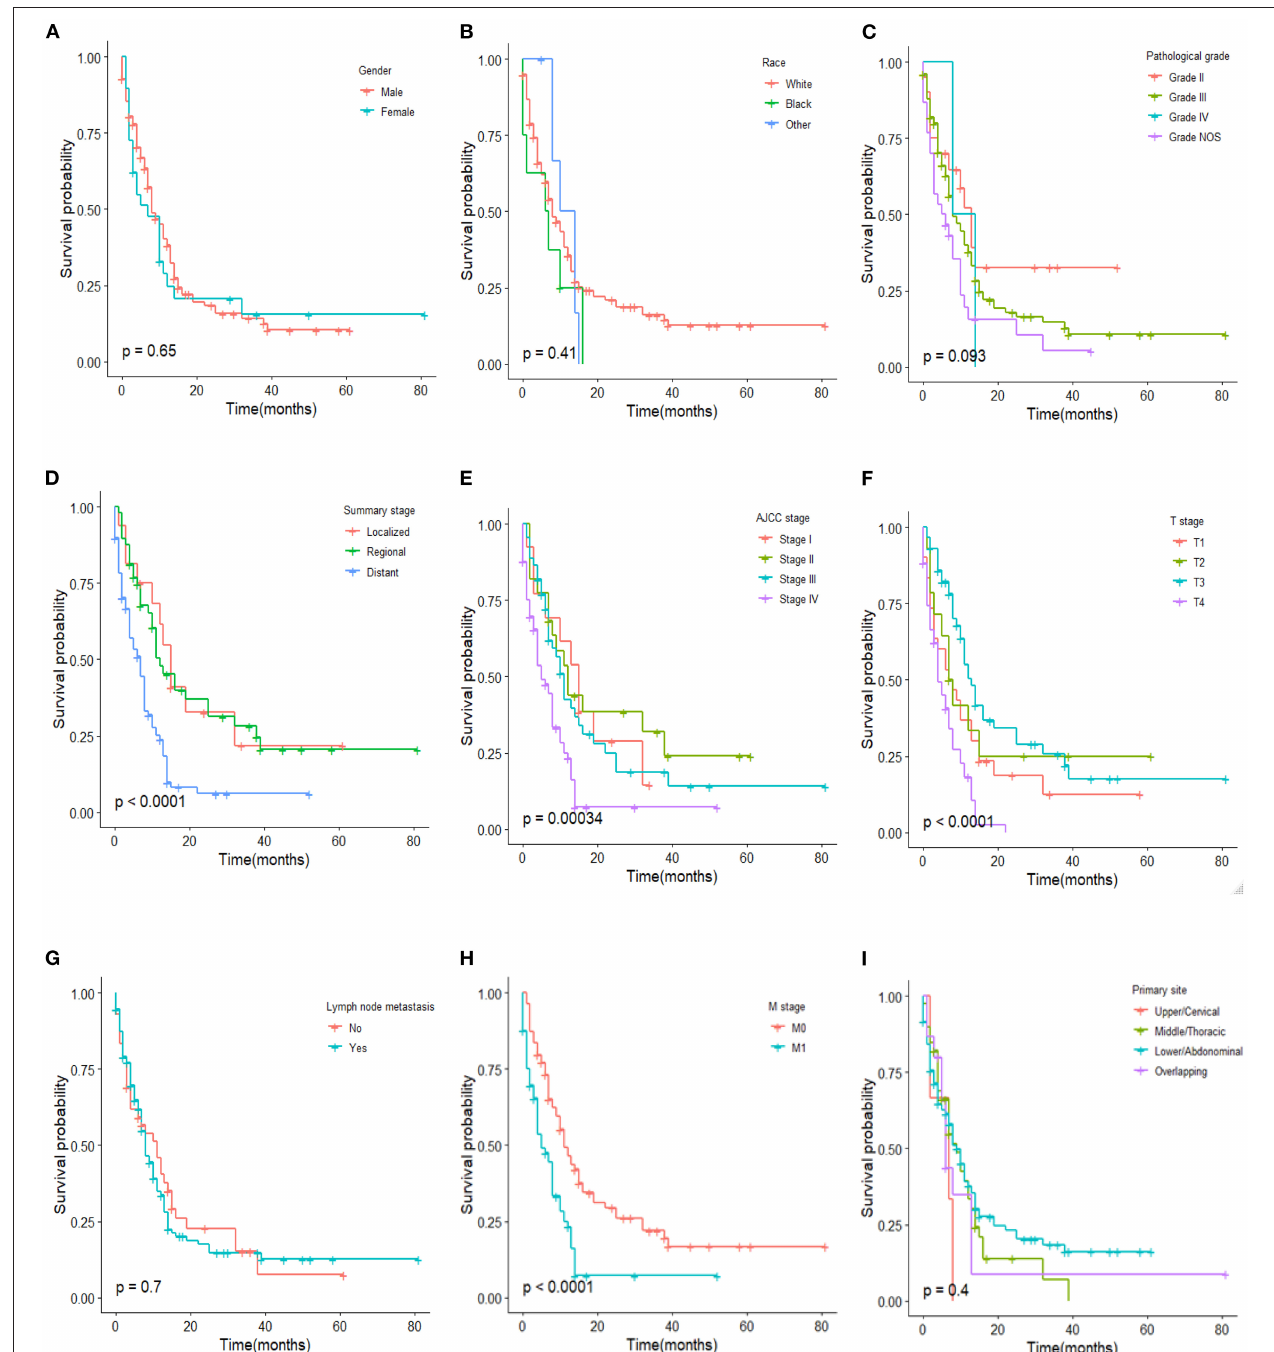
FIGURE 3 | Kaplan–Meier estimated overall survival in ASC patients stratified by gender (A) , race (B) , pathological grade (C) , summary stage (D) , AJCC stage (E) , T stage (F) , lymph node metastasis (G) , M stage (H) , primary site (I) .